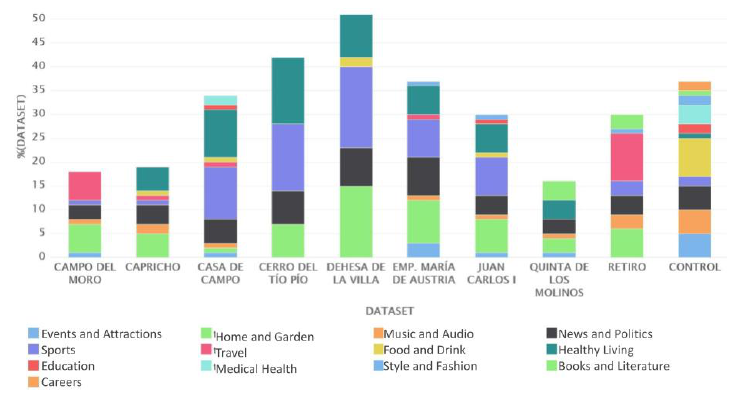
Figure 7. Topic analysis of the tweets from Madrid parks in